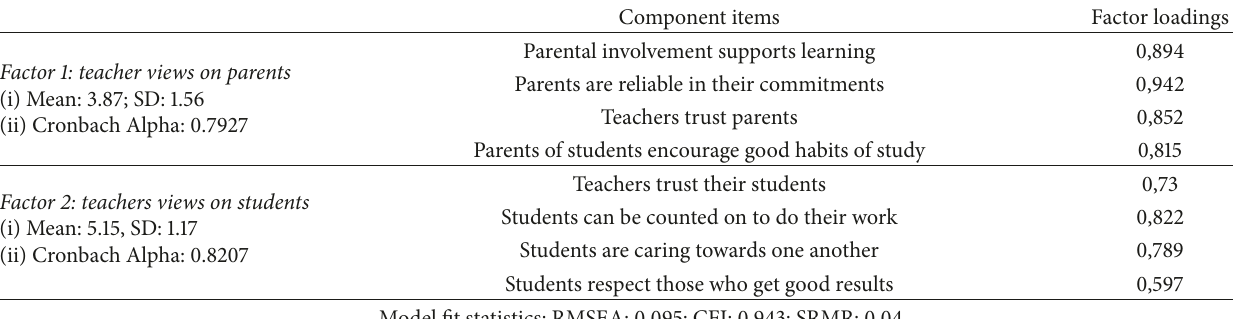
Table 7: Degree of agreement about quality of parent and student role in school. Teachers’ views (1 = not at all; 7 = very much in agreement ) ∗ . Component